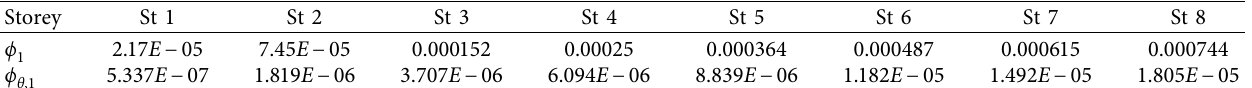
Table 6: First - mode mode shapes.